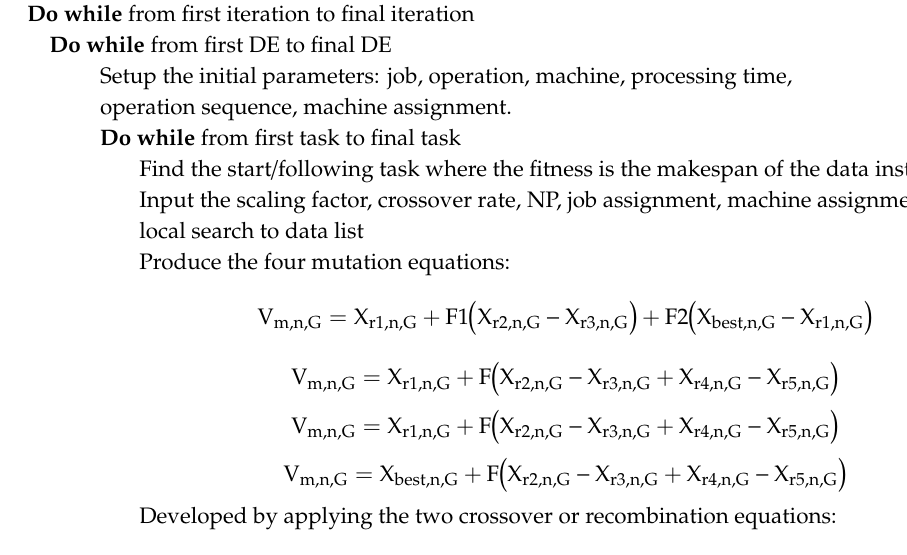
Algorithm 1. Pseudo-code of the improved DE for the FJSP Setup the initial DE